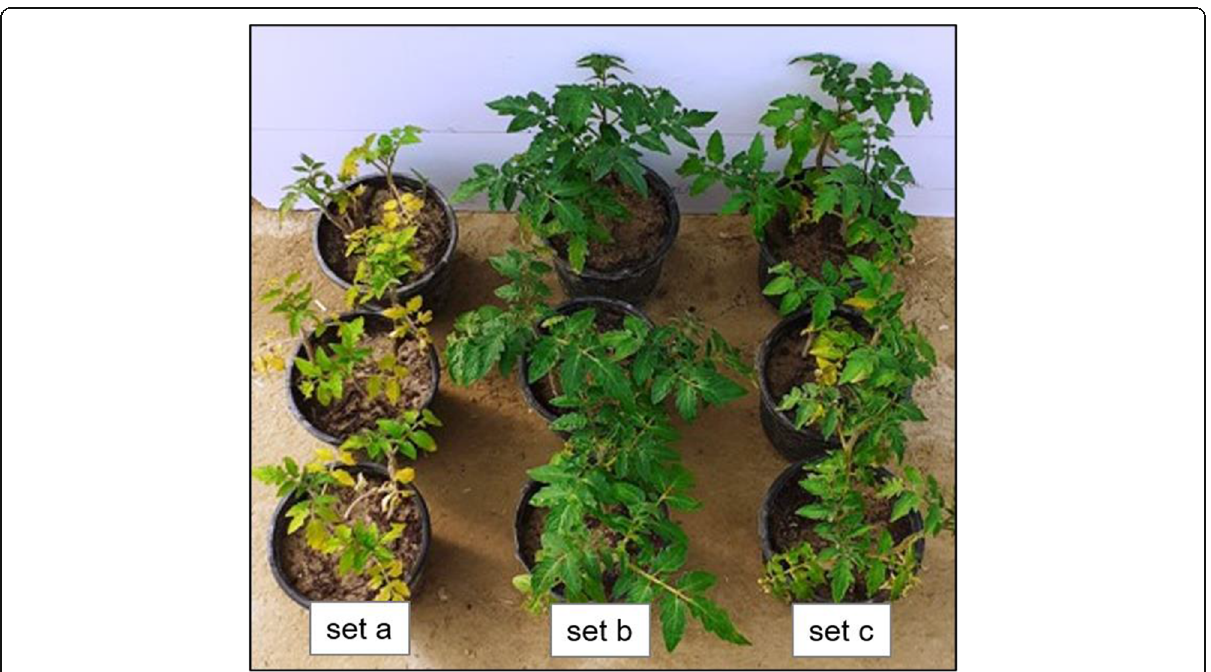
Fig. 6 Plant bioassay on tomato seedlings infected with Ralstonia solanacearum 1629 (R1629). Set a — R 1629 inoculated plants showing wilting symptoms of grade 2. Set b — plants with ɸ sp1+ R 1629. Set c — uninoculated control